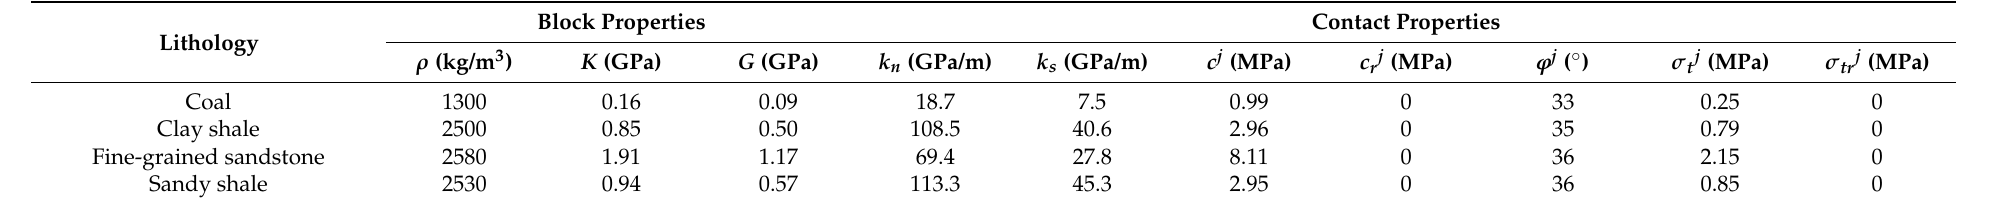
Table 3. Calibrated micro parameters of rock masses in the